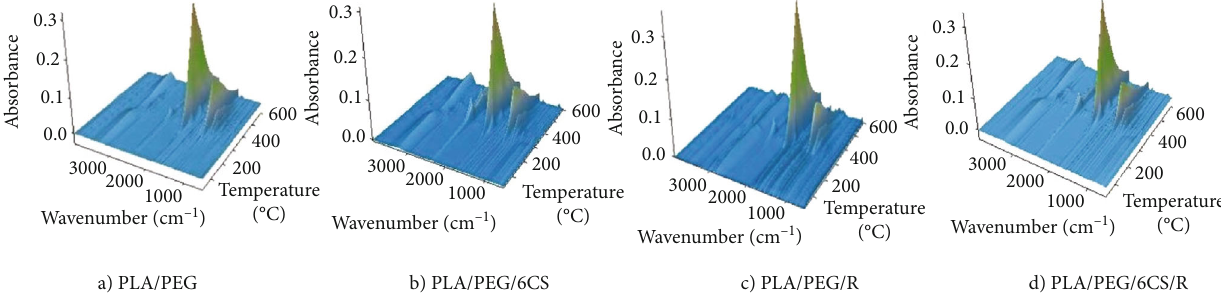
Figure 8: 3D FTIR spectra of the decomposition products of PEG-plasticized PLA